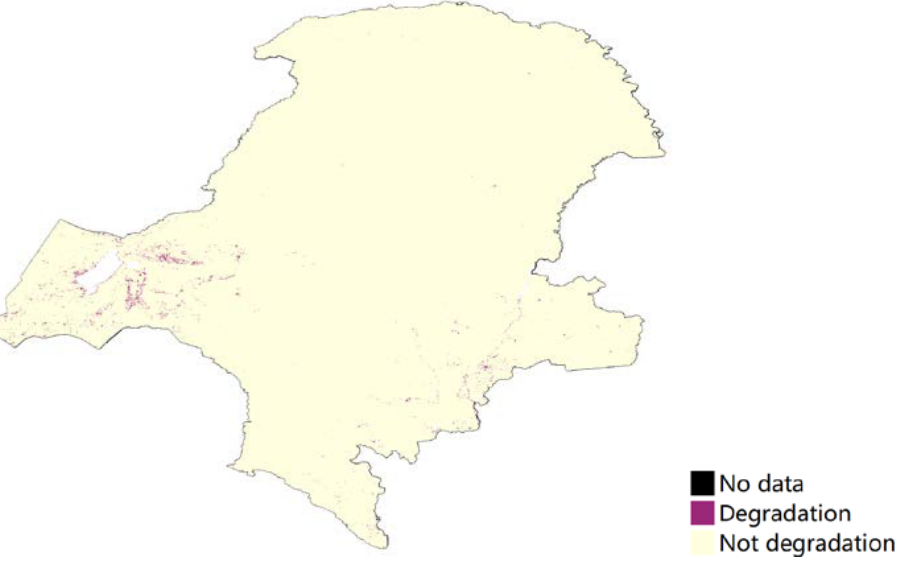
Figure 9. Land productivity performance degradation (2000–2018) in Great Khingan Mountain (GKM), China.